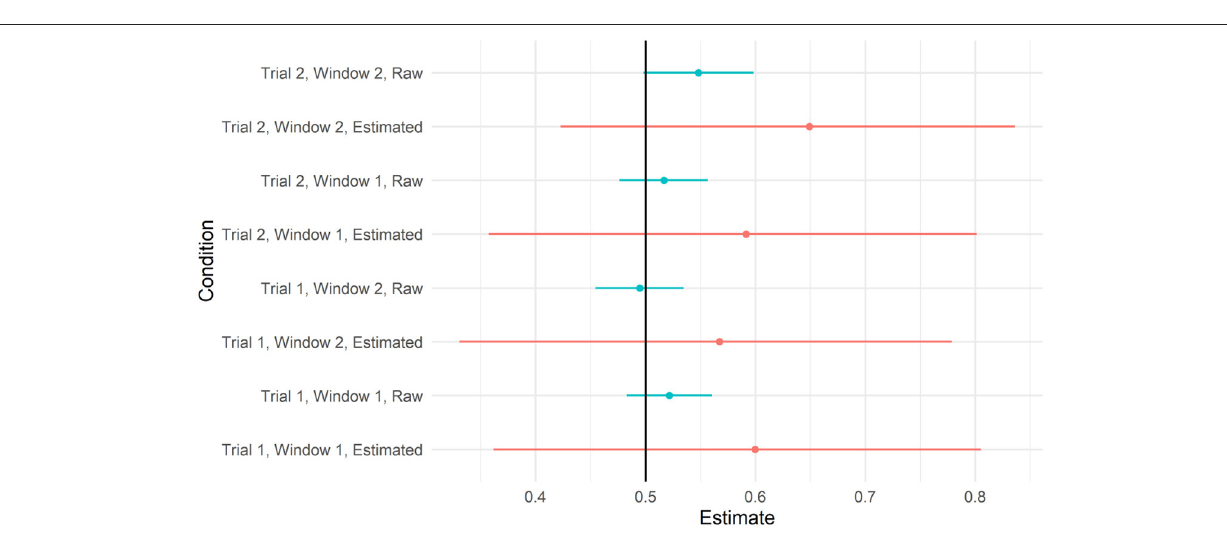
looks did not differ from 0, and the between-subject variance was quite